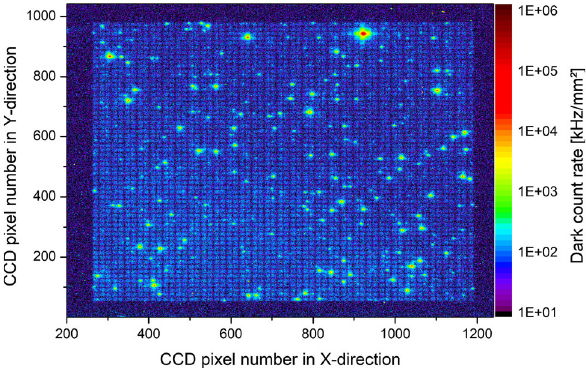
Fig. 19 Dark count rate map of the PM3350T MOD at Δ V = 5 . 4 V and t exp = 1 h. One CCD pixel corresponds to 10 . 43 µ m 2 of the SiPM